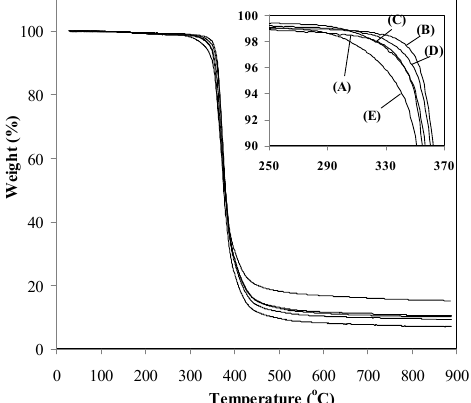
Figure 5. Thermogravimetric analysis (TGA) curves of (A) glassy epoxy (EPON 828RS + D ‐ 230 Jeffamine) and epoxy—clay nanocomposites with (B) Na + ‐ PGW, (C) I.30E, (D) I.28E (3 wt %, silicate basis), and (E) I.30E (6 wt %, silicate basis).